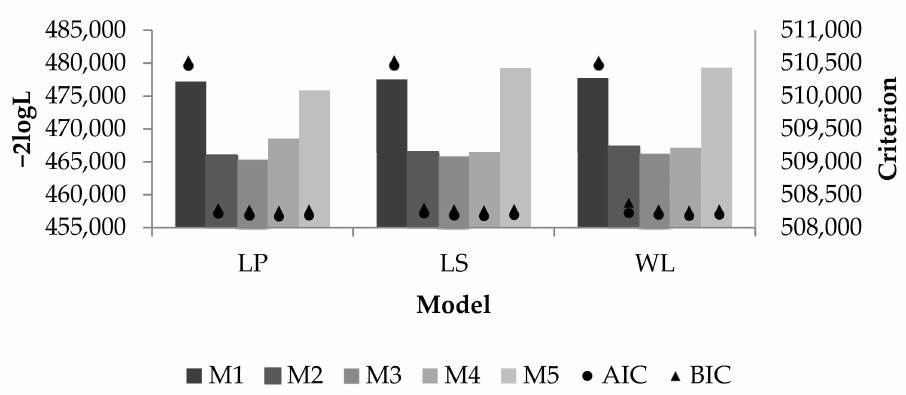
Figure 2. Estimates of maximum of likelihood function ( − 2logL), Akaike’s information criterion (AIC) and Schwarz’s Bayesian information criterion (BIC) according to evaluation model and random effects adjustment equation of test-day milk yield (TDMY) in Brazilian